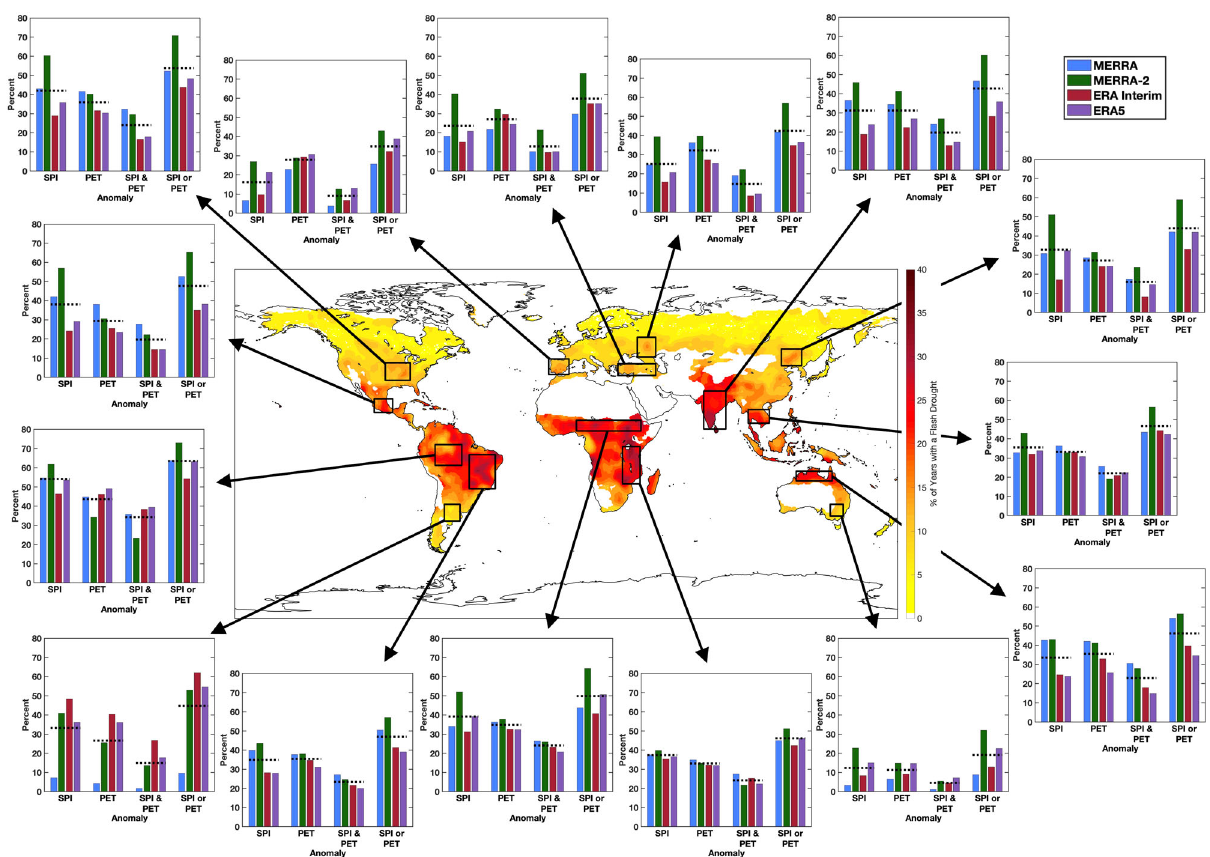
Fig. 4 Drivers of fl ash drought occurrence. Percentage of fl ash drought events with an SPI anomaly (SPI ≤ − 1), a PET anomaly (PET ≥ 1), an SPI and PET anomaly (SPI ≤ − 1 and PET ≥ 1), and an SPI or PET anomaly (SPI ≤ − 1 or PET ≥ 1) from the four reanalysis data sets (different colored bars) for each of the domains outlined in black on the map. The black dotted lines represent the mean between all four reanalysis data